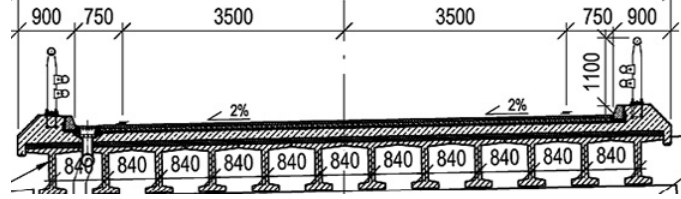
Figure 1. Cross-section of a bridge with pre-stressed string reinforced concrete